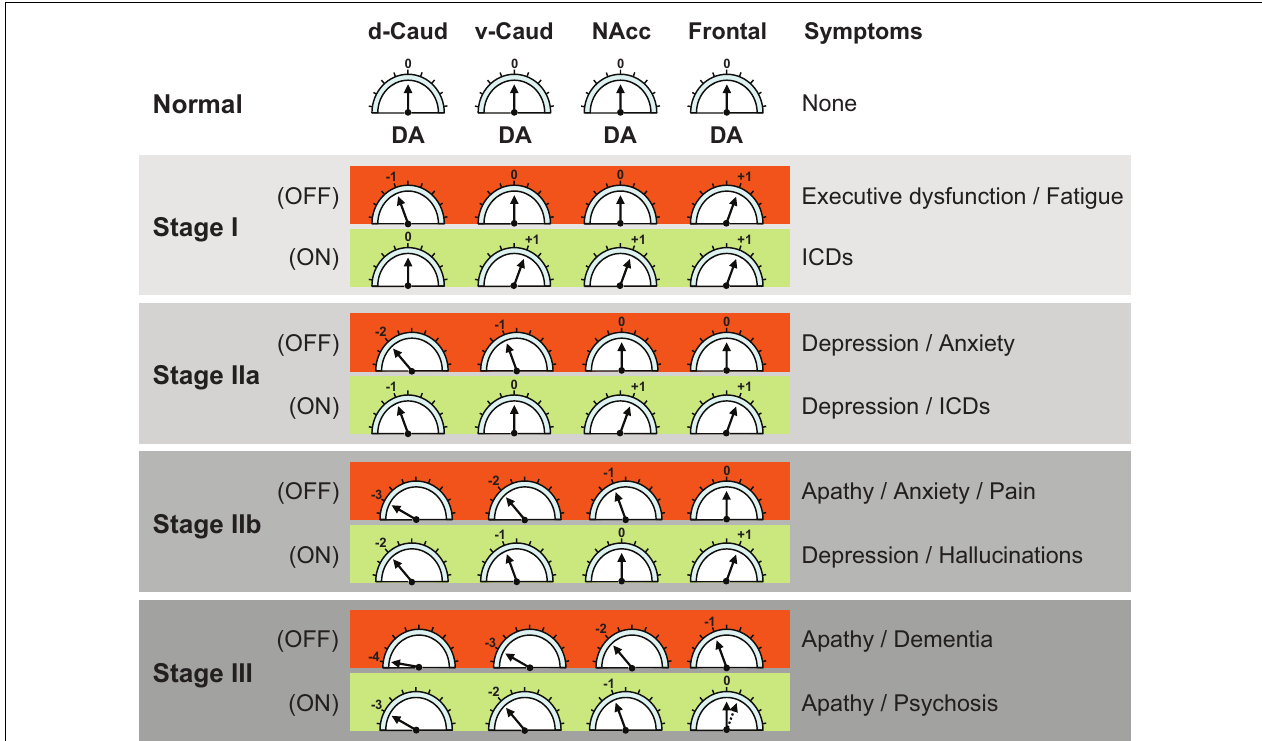
anterior cingulate cortex), a gradient of DA dysfunction may be also present in the mesocortical dopamine pathway (15).The DA tone can be optimal (0), too low (negative values) or too high (positive values).The direct DA projection to the frontal cortex seems to be initially upregulated (29), but with limited capability to increase further the DA tone in response to DA treatment because it lacks dopamine transporter sites and dopamine D2 autoreceptors (16). ICDs = impulse control disorders. Adapted from Ref.